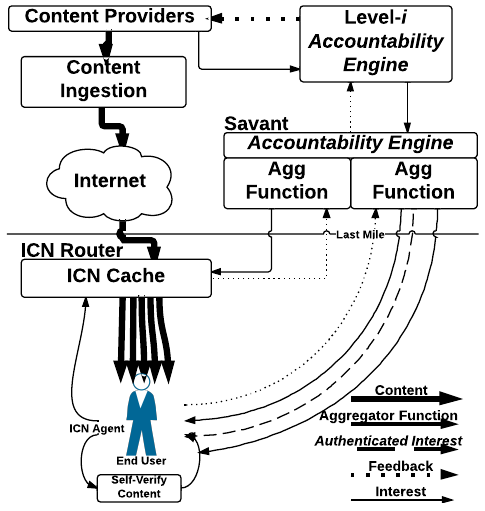
Fig. 1. The ICN architecture with the Savant framework component